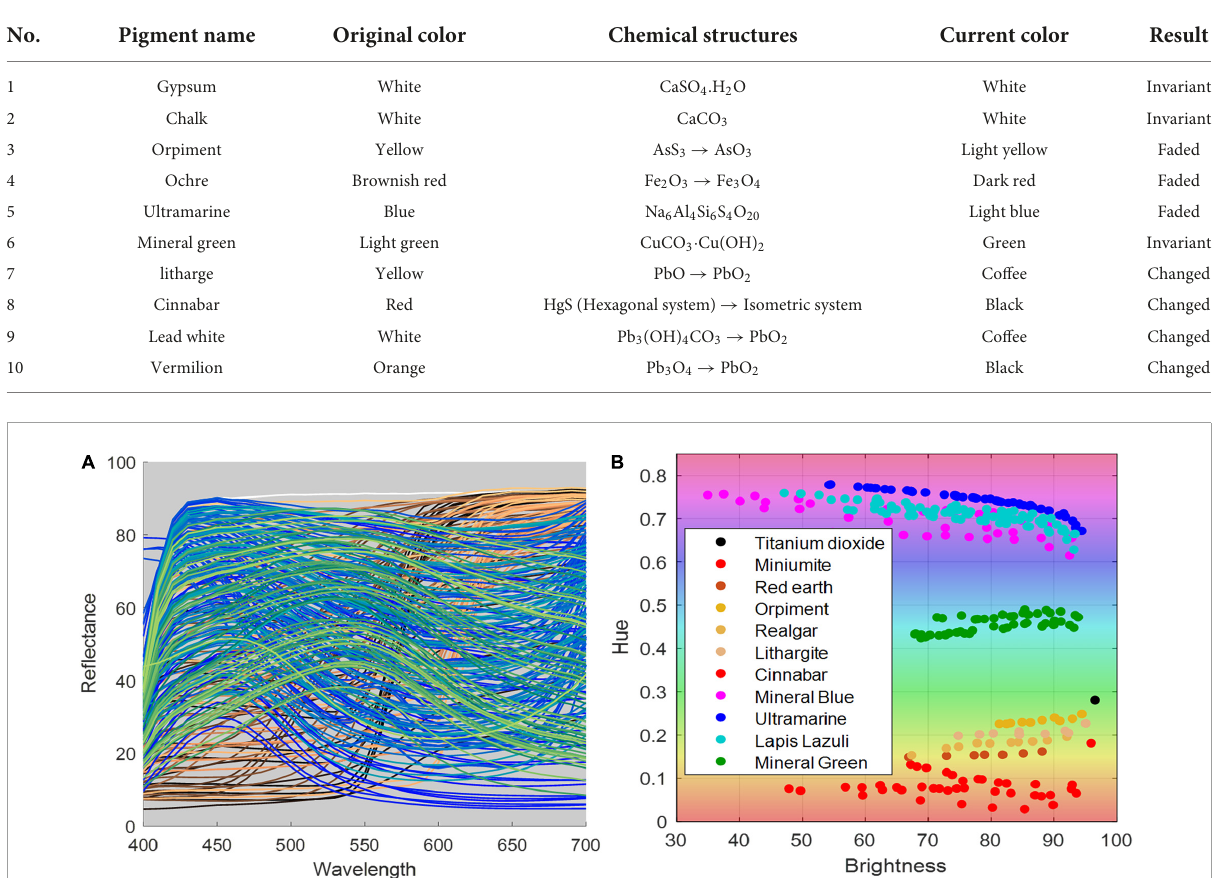
TABLE 1 The structure and properties of pigments in the Mogao Grottoes.